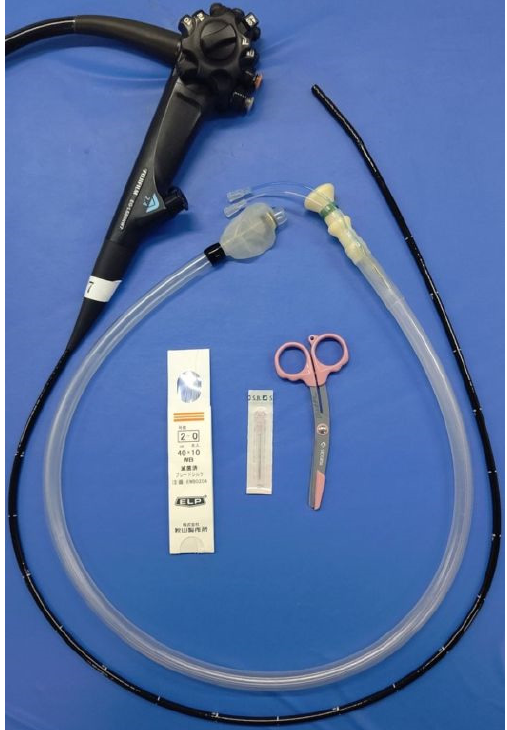
Figure 1. Experimental equipment.